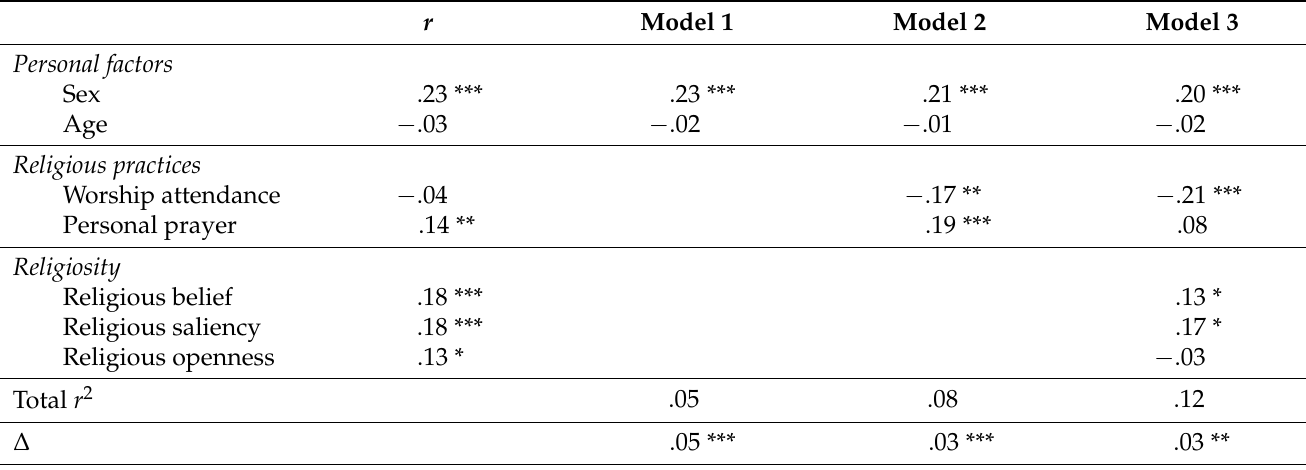
Table 5. Regression models on Scale of Attitude toward Socio-economic Human Rights (SASHR).